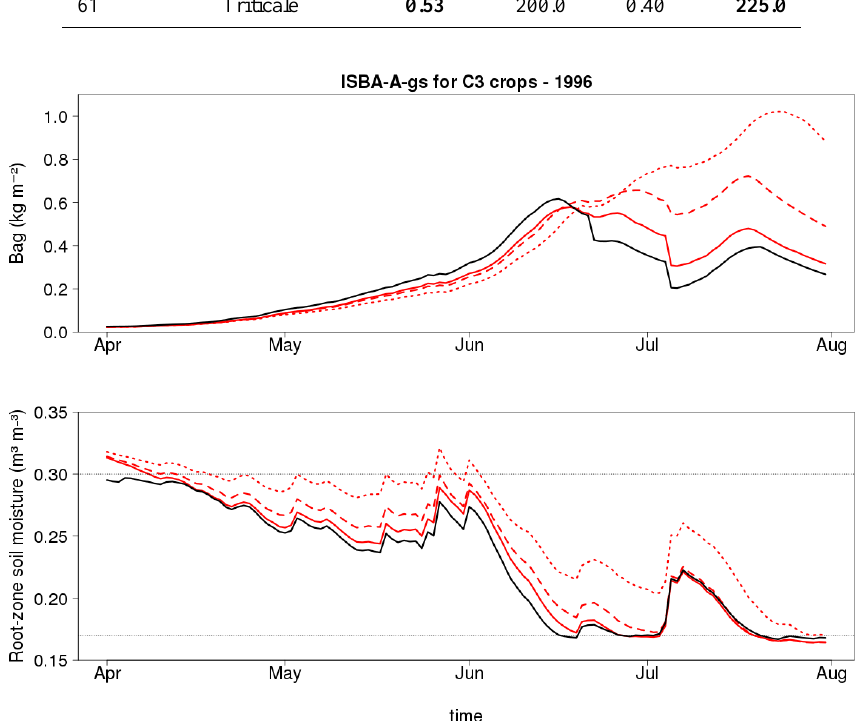
Figure 11. Simulations in 1996 for C3 crops ( g m = 0.5mms − 1 , MaxAWC = 75mm) in the 08-Ardennes département of (top panel) above- ground biomass and (bottom panel) root-zone soil moisture in the DIF1, DIF2, DIF3 and FR-2L configurations (red solid, red dotted, red dashed, and black lines, respectively). The grey lines indicate the root-zone soil moisture values at field capacity and at wilting